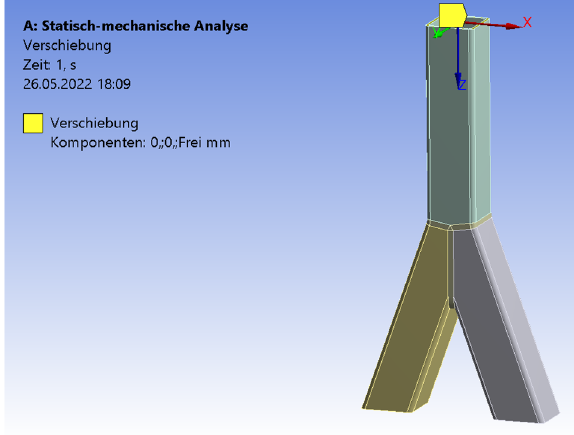
Figure 7. Boundary conditions. Numerical model.